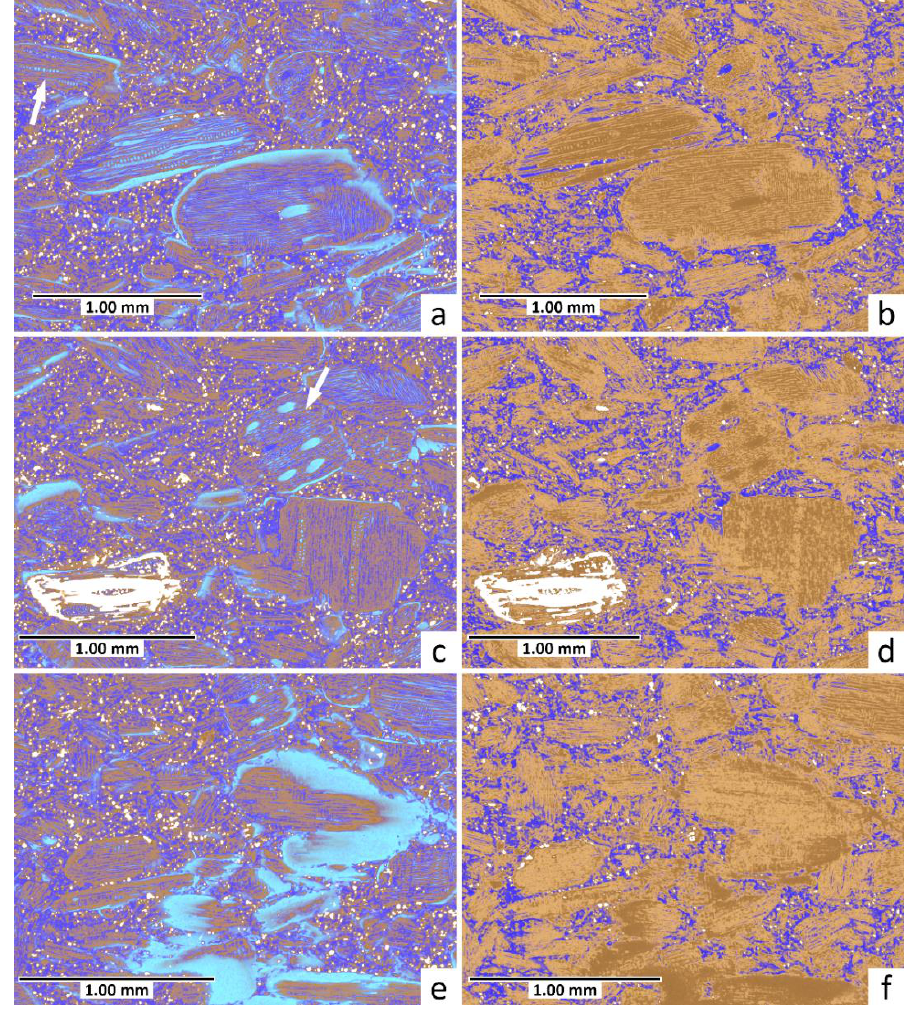
Figure 2. Two-dimensional (2D) tomographic images of the wood plastic composite: before ( a , c , e ) and after ( b , d , f ) impregnation with sodium iodide; brown = wood; navy blue = plastic; light blue = void; white = zinc borate.